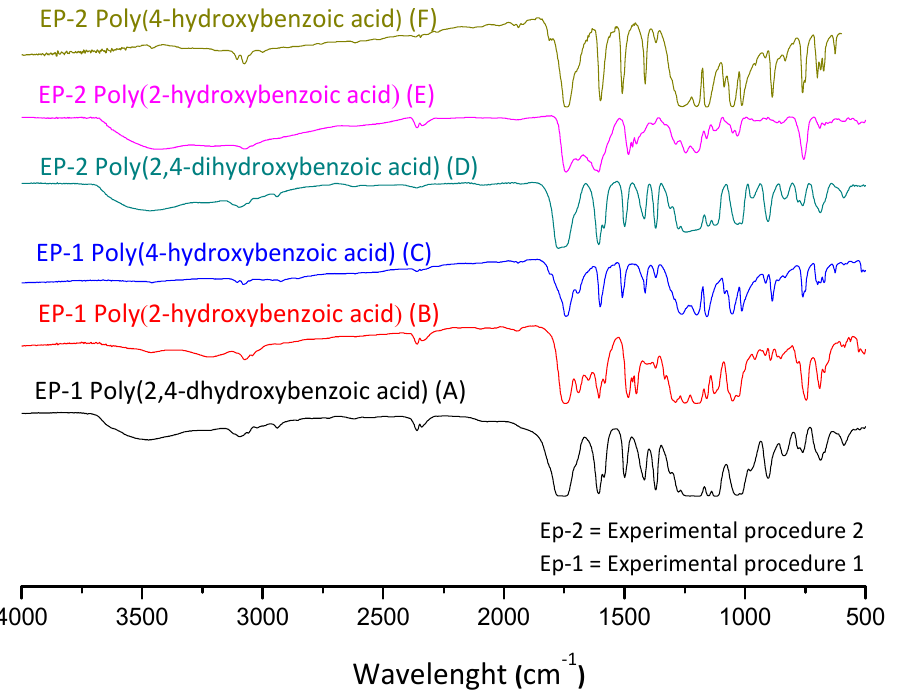
Figure 6. FTIR spectra of the polyesters obtained from experimental procedures 1 and 2.